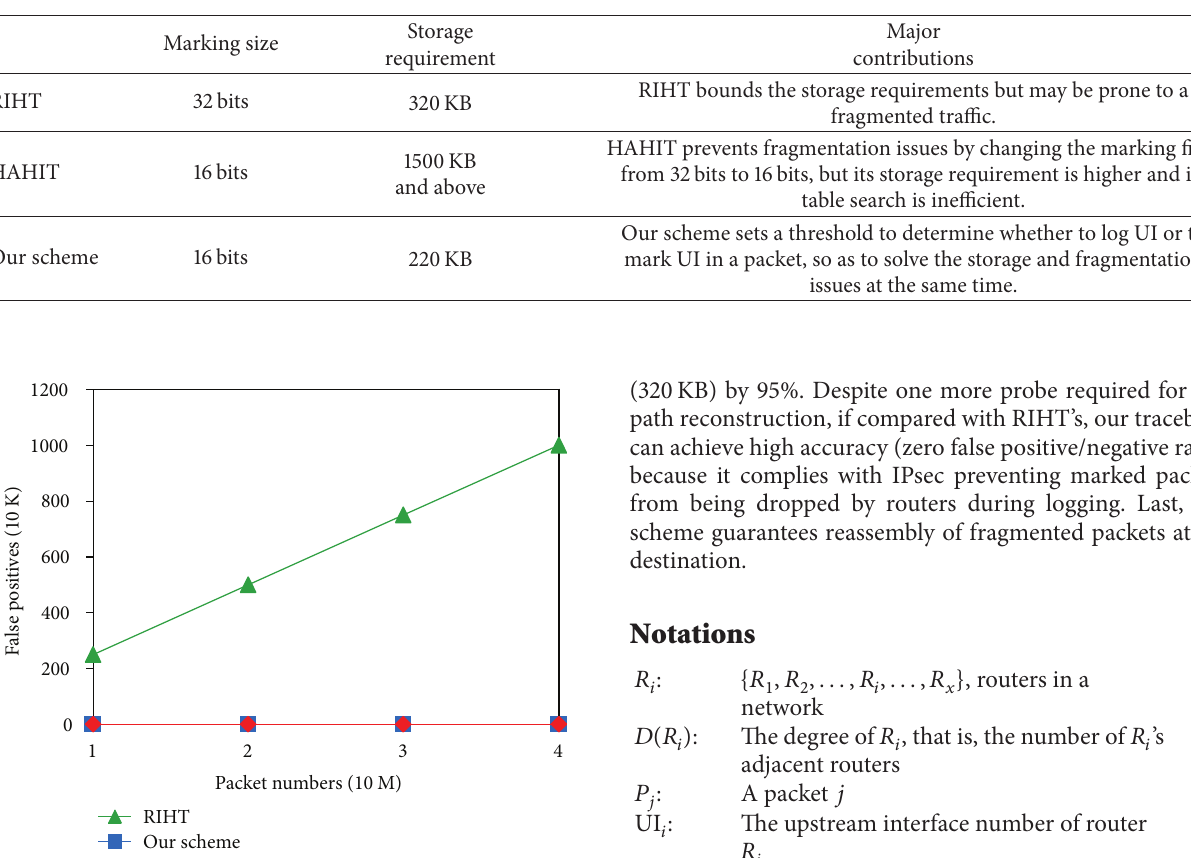
Table 3: Comparison results.